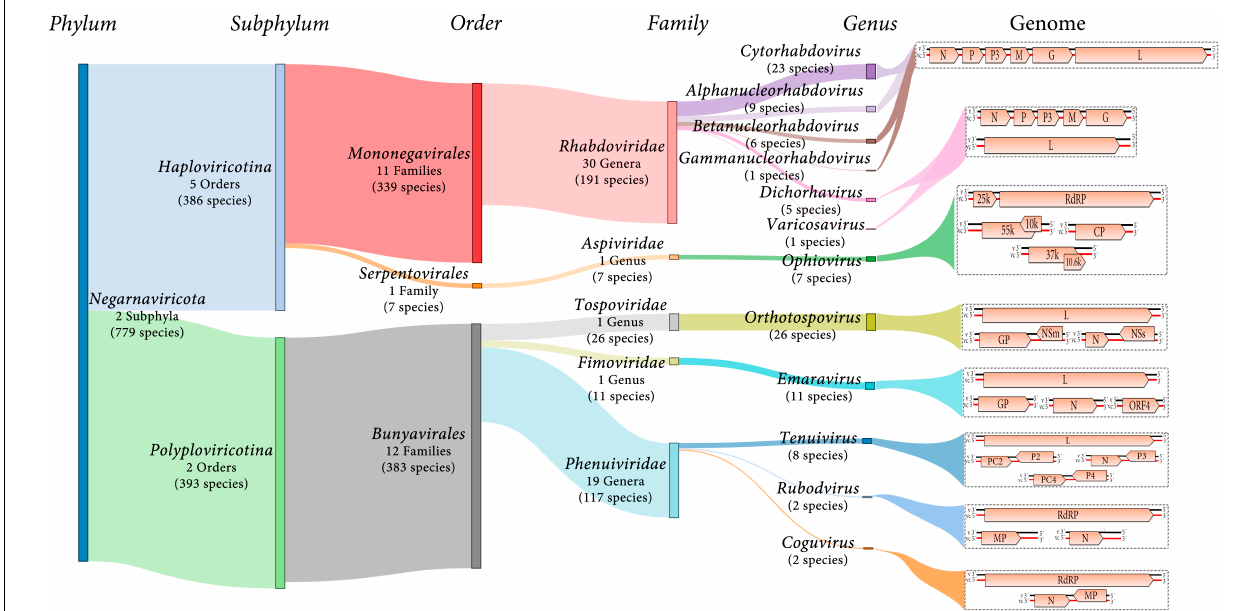
( Table 1 ). Furthermore, the use of HTS has allowed